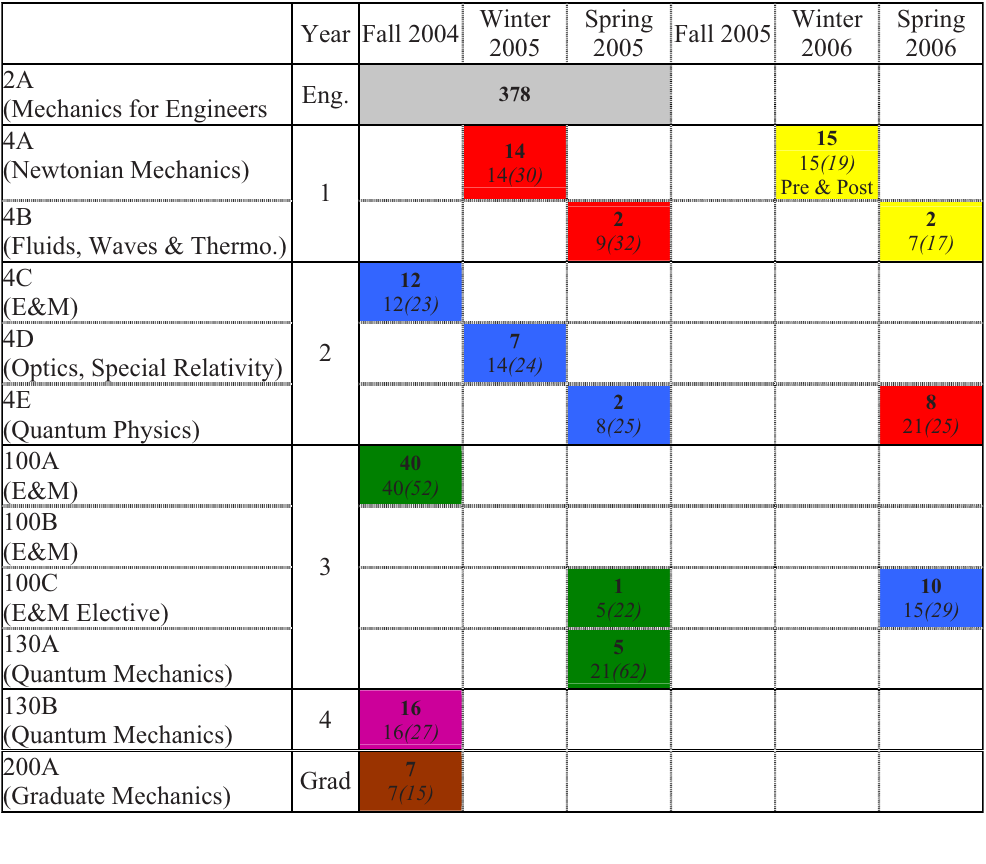
TABLE I. (cid:1) Color (cid:2) Courses surveyed, with information about topic covered, which year students typically take course, number of respondents for each year, average and standard deviation of the percentage of favorable responses for each year, and academic quarter during which each course was surveyed. For the physics major courses (cid:1) all except 2A (cid:2) , same-colored cells indicate a cohort of students who may have been surveyed multiple times. Cell key: upper: number of surveys included in cross-sectional analysis and lower: number of respondents (cid:1) number of enrollees (cid:2)